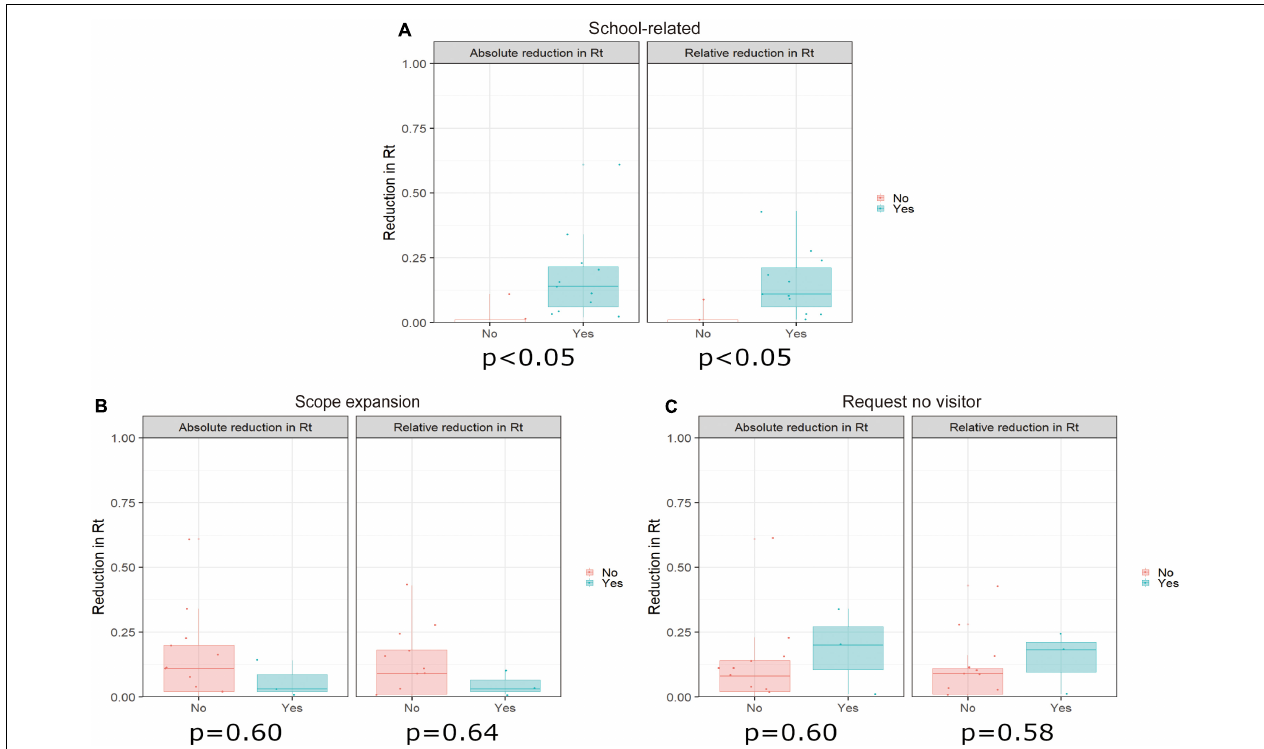
FIGURE 2 | Relationship between pre-emergency measure (PEM) categories and reduction in the effective reproduction number ( R t ) compared with the 7 days before intervention (baseline period). This figure shows the relationship between the reduction in R t during the 7 days prior to the intervention and during the 7 days after the intervention and presence of each PEM intervention. The only PEM categories for which there were differences in adoption among prefectures were (A) school-related measures, (B) expansion of the intervention scope (a pre-emergency intervention originally implemented in only part of a given prefecture was expanded to additional areas), and (C) requests (from the prefecture) for no out-of-prefecture travel. We calculated p-values using the Wilcoxon signed-rank test. The left-hand panel in each figure shows the absolute reduction in R t and the right-hand panel shows the relative reduction in R t